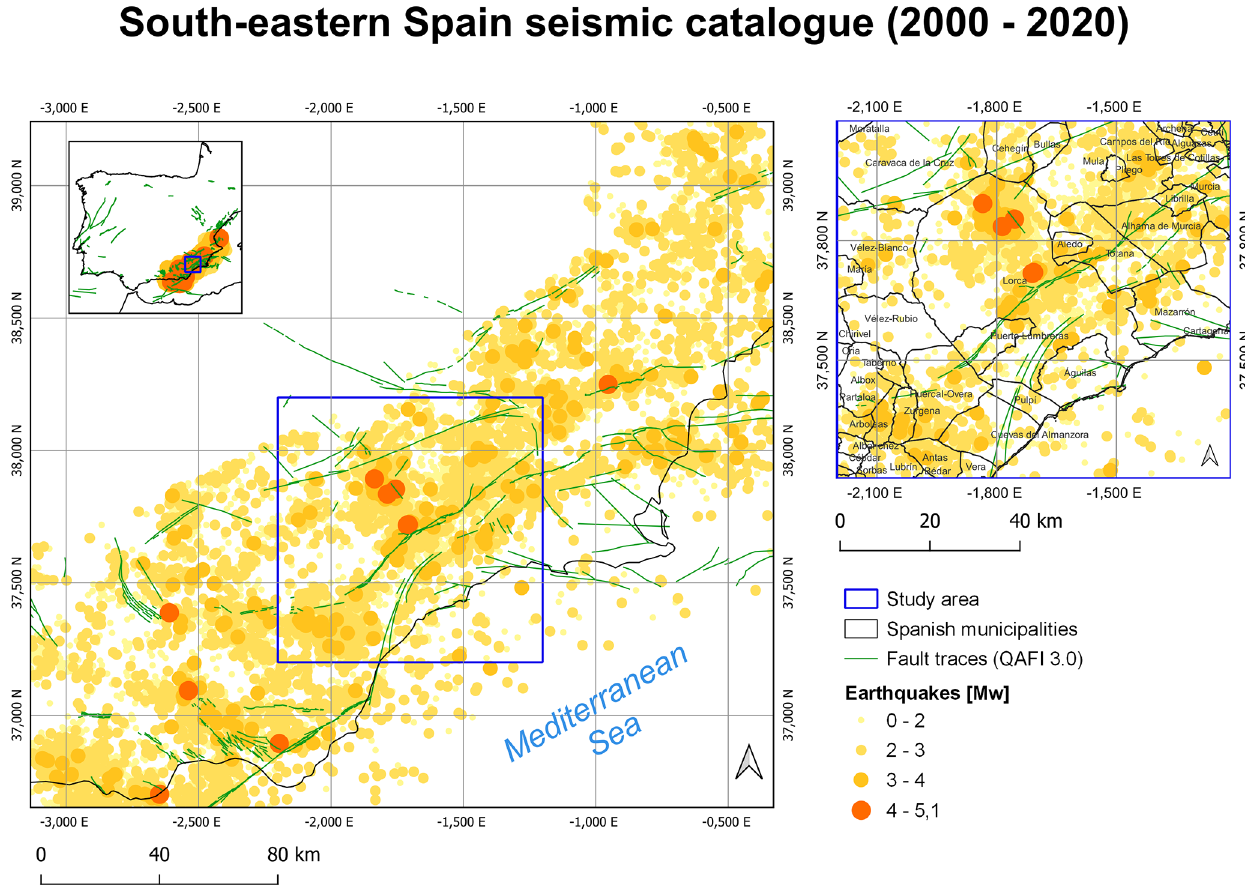
Figure 8. Southeastern Spain seismic catalog, zoom over the Lorca area (right) and fault traces in green from QAFI 3.0 (García-Mayordomo et al.,